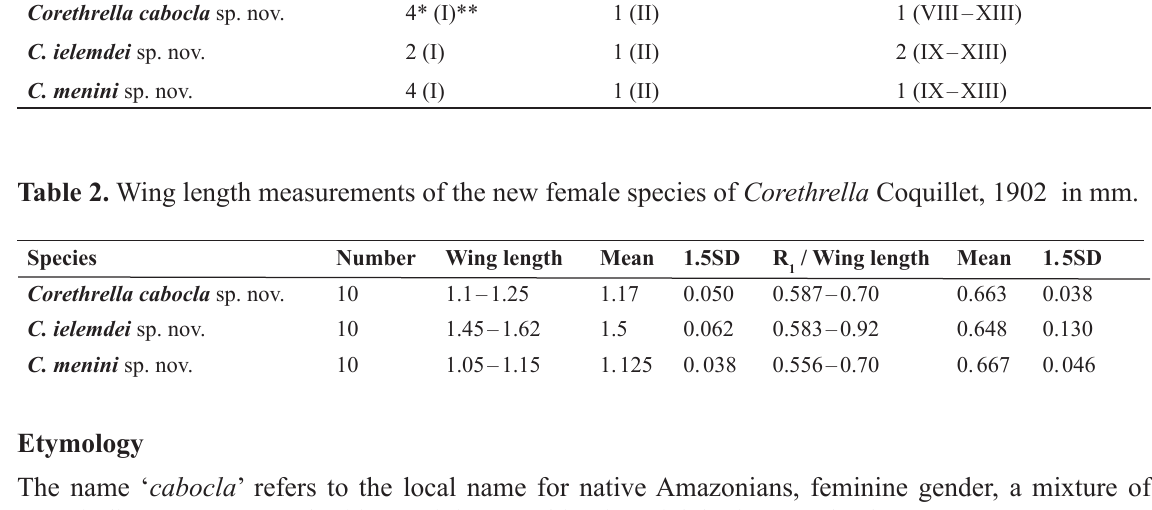
Table 1. Distribution of sensilla coeloconica along the flagellar segments of the new species of Corethrella Coquillet, 1902. *Arabic numerals = number of sensilla; **Roman numerals = flagellomere number.